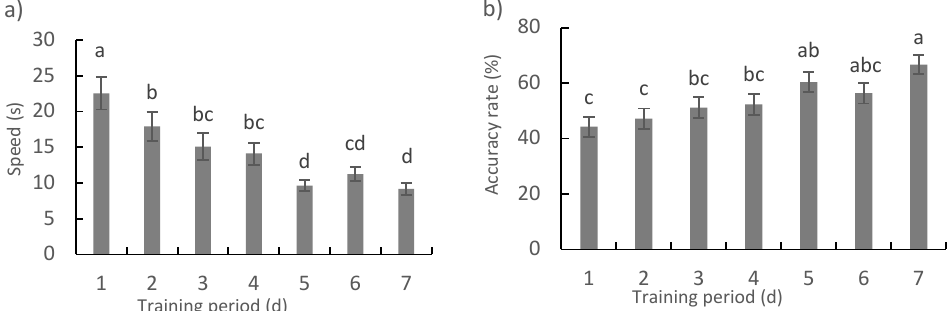
Figure 2. The speed ( a ) i.e., time when fish first arrived at arm with food, and accuracy rate ( b ) i.e., proportion of fish that first entered the arm with food rather than an arm without food, for the foraging task in the maze during the training period (means ± S.E., n = 55). Note: a, b, c, d letters suggest a significant difference of the variables after different days of training ( p < 0.05). Table 1. Results of the memory retention test, i.e., comparison of speed and accuracy rate after 7 d of training with those for the same fish following a different period of detraining based on a linear mixed ‐ model analysis (parameter data are presented as means S.E.).